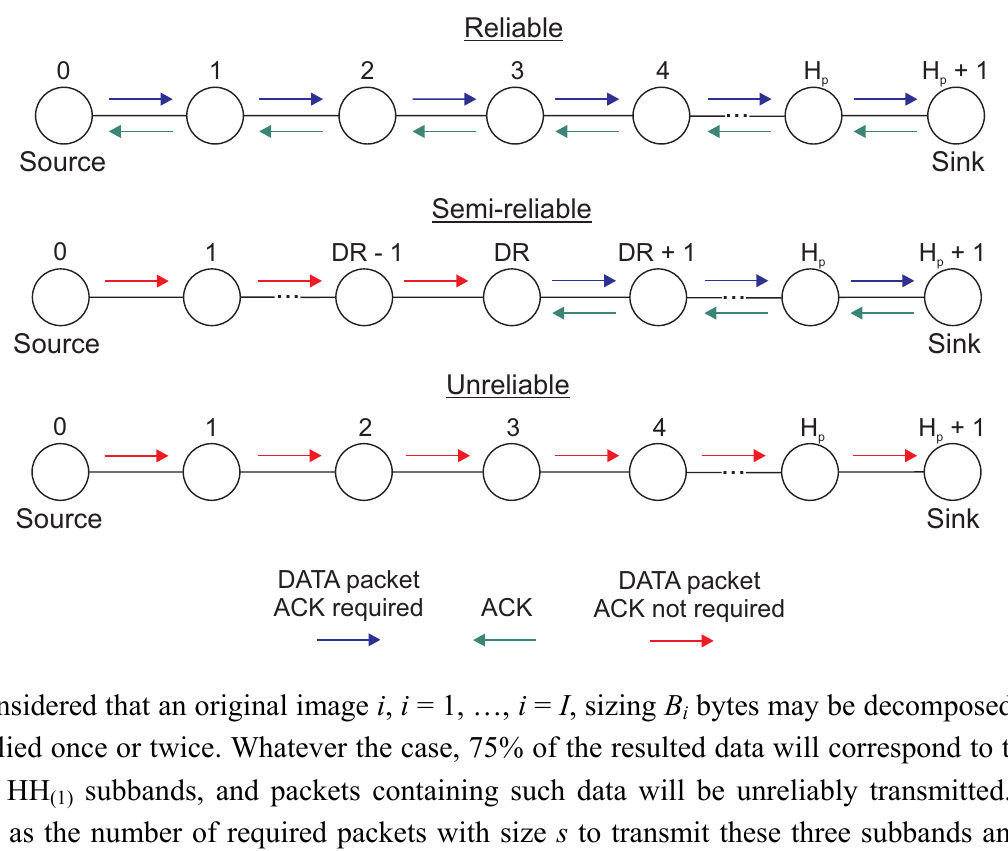
Figure 4. Reliable, semi-reliable and unreliable transmission